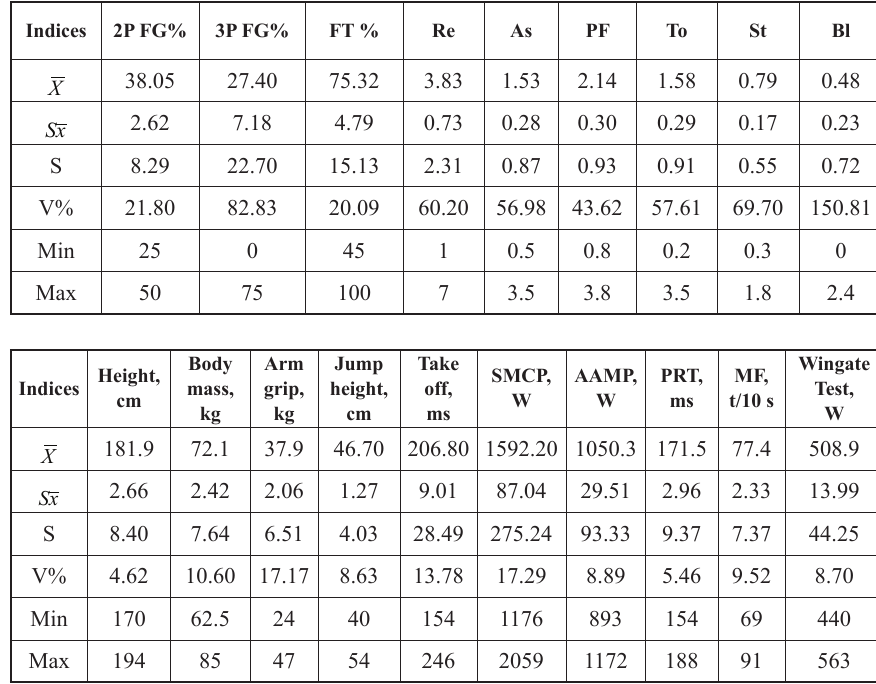
Table 1. Statistical indicators of competition performance of high level female basketball players